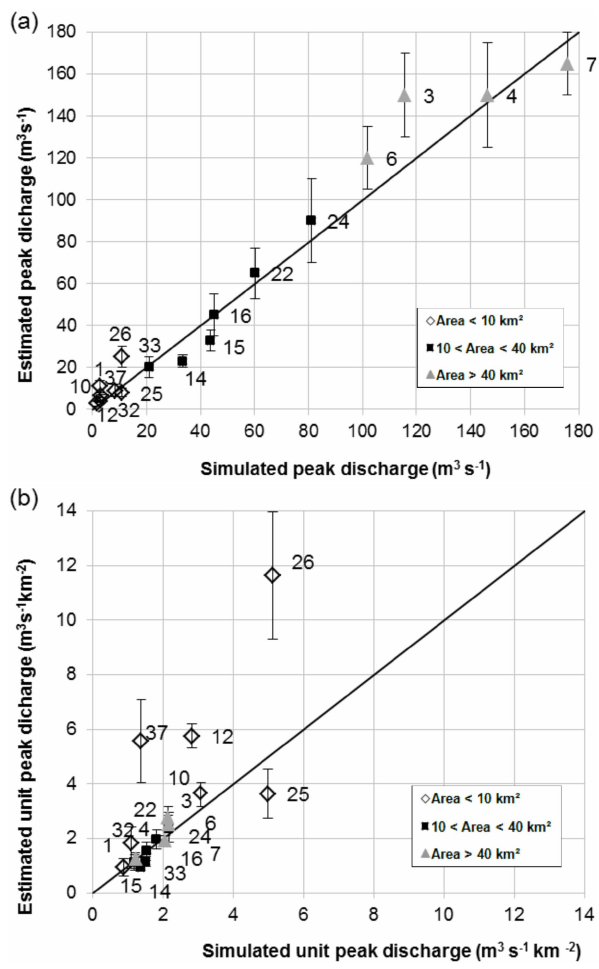
Fig. 13. Result from runoff model applications over the 17 IPEC catchments, by considering uncertainty ranges in indirect peak discharge estimation: (a) estimated versus simulated peak dis- charges; (b) estimated versus simulated unit peak discharges. Nash Sutcliffe efficiency statistics are 0.92 and 0.45, respectively.